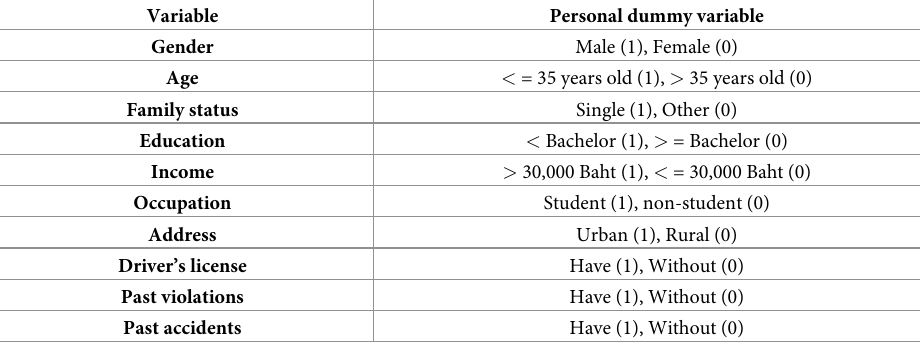
Table 2. Personal characteristics for the within-group level